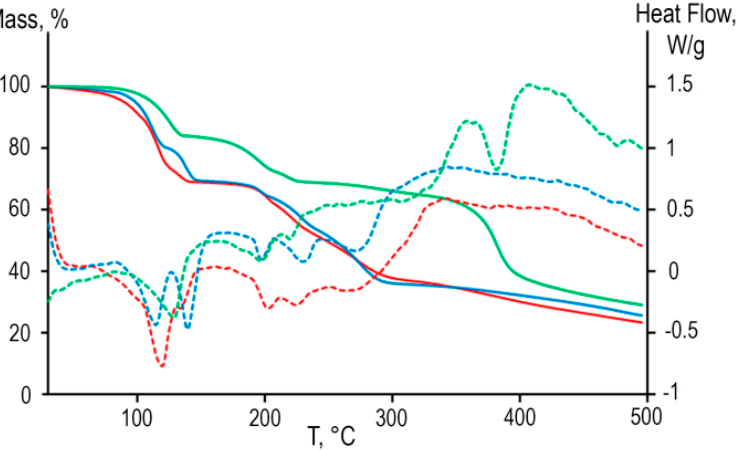
Figure 7. Hydrogen bonds in 1 ( left ) and 2 ( right ) crystals.